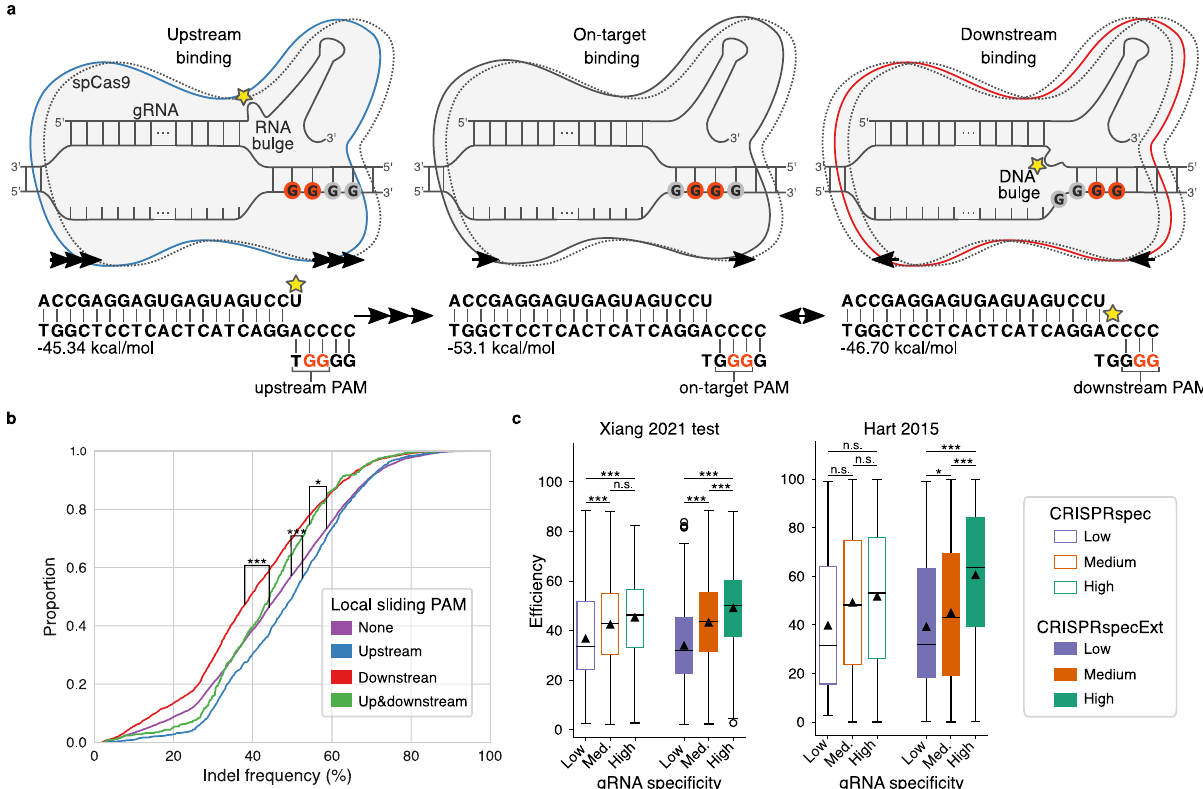
Fig. 3 Impact of local sliding PAMs on gRNA ef fi ciency and speci fi city. a Cas9-gRNA binding model in which guanine stretches upstream and downstream from the on-target PAM can function as local sliding PAMs at which the gRNA forms a bulged hybrid with the target DNA. The direction of Cas9 sliding is indicated with arrows, and the upstream and downstream sliding complexes are coloured in blue and red, respectively. Bulges are indicated by yellow stars. Stretches of guanine (G), representing possible PAM binding sites, are reported in the drawing and highlighted in red if used by the complex. b Cumulative distributions of indel frequencies of gRNAs categorised by the presence of local sliding PAMs at their targets (one-way ANOVA p value = 3.59E-57). Downstream n = 2239; upstream n = 1339; none n = 7565; up and downstream n = 459. T- test p value comparing upstream- none = 1.96E-10 (one-sided), downstream-none = 1.50E-40 (one-sided), up and downstream-none = 3.69E-02 (two-sided). c Boxplots of gRNA ef fi ciencies from two datasets binned into low, medium and high CRISPRspec or CRISPRspecExt groups before (left) and after (right) the addition of local sliding contributions. Boxes represent the fi rst and third quartiles (Q1 and Q3). The median is shown as a line and the mean by a triangle; whiskers extend up (or down) to the last (or fi rst) value lower (or greater) than Q3 + 1.5*(Q3-Q1) (or Q1-1.5*(Q3-Q1)). Number of elements: 'Xiang 2021 test', CRISPRspec low n = 204, medium n = 1788, high n = 227, CRISPRspecExt low = 477, medium = 1377, high = 365; 'Hart 2015', CRISPRspec low = 18, medium = 1019, high = 204, CRISPRspecExt low = 79, medium = 774, high = 388. One-sided Kolmogorov – Smirnov two-sample test, Bonferroni-corrected within